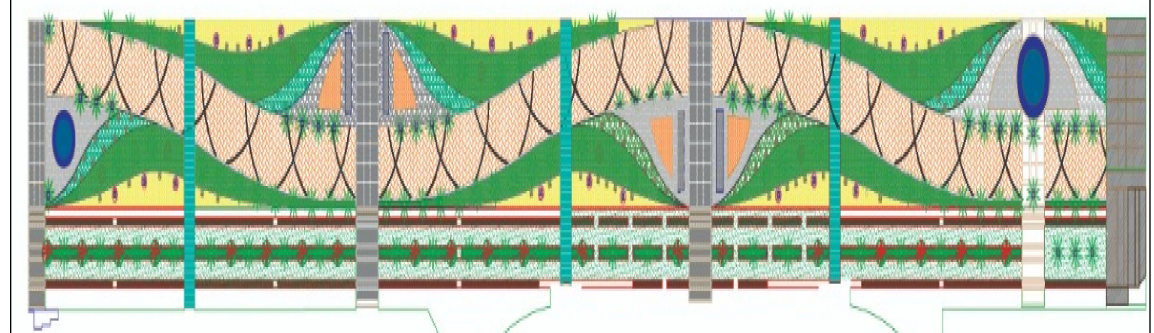
Figure 12. Applying xeriscape for walkway landscape area. Xeriscaping softscape design (Details of water consumption is shown in Table